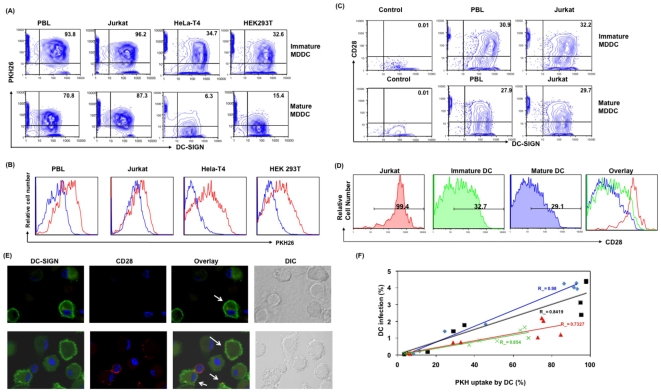
Infected T cell mediated DC infection is directly correlated with the ability of DC to acquire antigen from T cell.(A) Immature and mature MDDC were cocultured with PKH26-labeled PBL, Jurkat cells, HeLa-T4 or HEK 293T at a ratio of 1∶1. Post coculture (12 hours) cells were stained for DC-SIGN and the amount of PKH26 uptake by DC-SIGN positive cells were assessed by flow cytometry. DC were gated based on side scatter and forward scatter followed by doublet discrimination. Values in upper right quadrant indicate the percentage of DC-SIGN and PKH26 positive cells. (B) Histogram overlay represent PKH26 fluorescence in immature (Red) and mature (Blue) DC, post cocultured (12 hours) with PKH-26 labeled PBL, Jurkat cells, HeLa-T4 or HEK 293T cells. The figure is representative of data obtained from experiments in four separate donors. (C) Immature and mature DC cocultured (for 12 hours) with PBL or Jurkat T cells were stained for DC-SIGN and CD28 and evaluated by flow cytometry. (D) Comparison of MFI of CD28 molecule on the surface of Jurkat, immature DC or mature DC cocultured with Jurkat T cells. (E) Immature DC were cocultured with Jurkat T cells for twelve hours, cells were stained for DC-SIGN and CD28 and evaluated by Immunofluorescence microscopy, green represents DC-SIGN, CD28 is depicted in red and DAPI staining of nucleus is shown in blue. DC alone control was included. (F) Scatter plot denotes the correlation of PKH26 uptake and DC infection post coculture with different cell types. Each color in the plot denotes individual donor (n = 4). Linear regression was calculated for each donor, along with the R2 value.